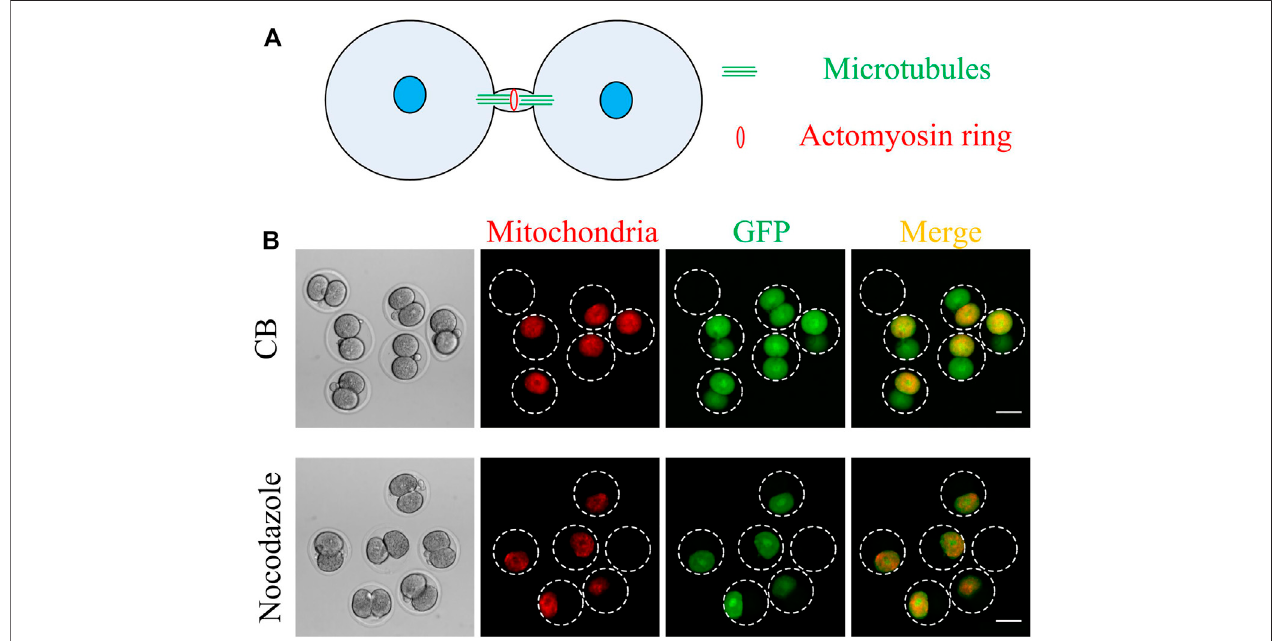
FIGURE 4 | Nocodazole, but not cytochalasin B, inhibits cytoplasmic GFP transport between the two daughter cells. (A) A schematic of an intercellular bridge (modi fi ed from Chen, C. T. et al. Nature reviews. Molecular cell biology 2012, 13, 483 – 488). Microtubules and actomyosin rings are two of the most important components of the intercellular bridge. The microtubule is parallel, and the actomyosin ring is perpendicular to the intercellular bridge. (B) After 1 h of mouse embryo morphologically divided into two cells, the mRNA expressing GFP and mitochondrial localized RFP was microinjected into one daughter cell. Then the embryos were cultured with nocodazole or cytochalasin B for 7 h and then imaged. Scale bar (cid:1) 50 μ m.